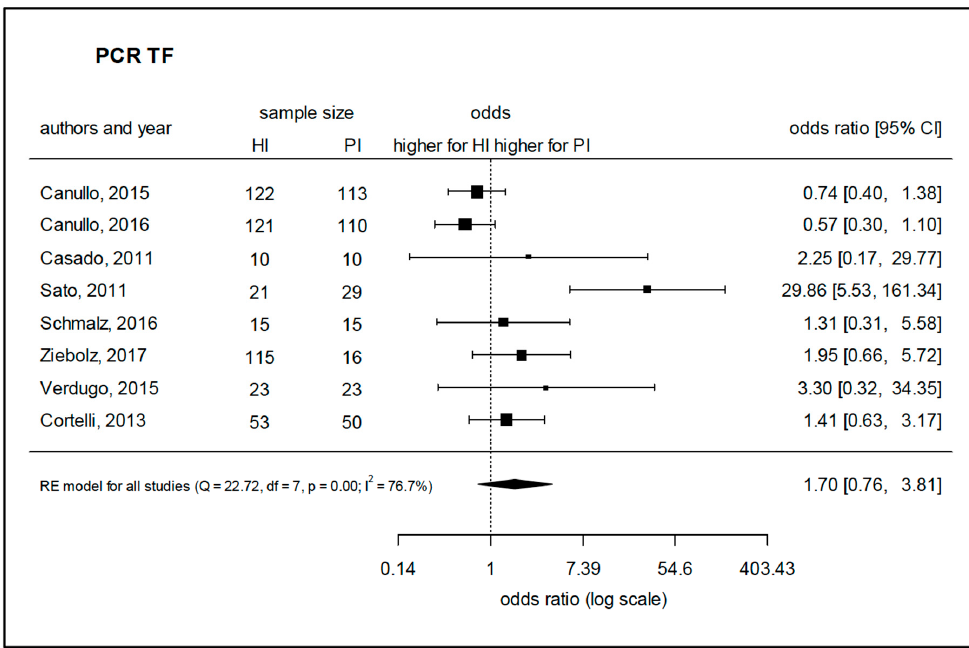
Figure 6. Meta-analysis for the presence of Tannerella forsythia in either healthy sites or peri-implantitis sites (studies performing PCR-based analysis). HI—healthy implants, PI—implants with peri-implantitis, Q—Cochrane’s Q, df—degrees of freedom, p —level of significance, I 2 —proportion of observed variance